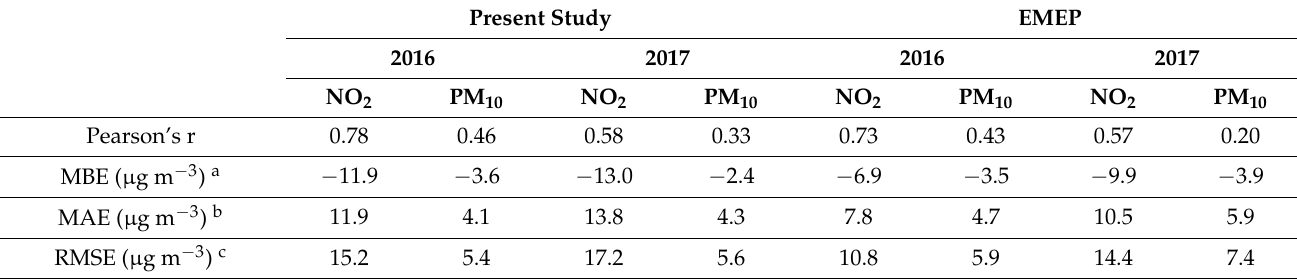
Table 1. Model quality indicators calculated for this study, as well as the results reported by the EMEP. Present